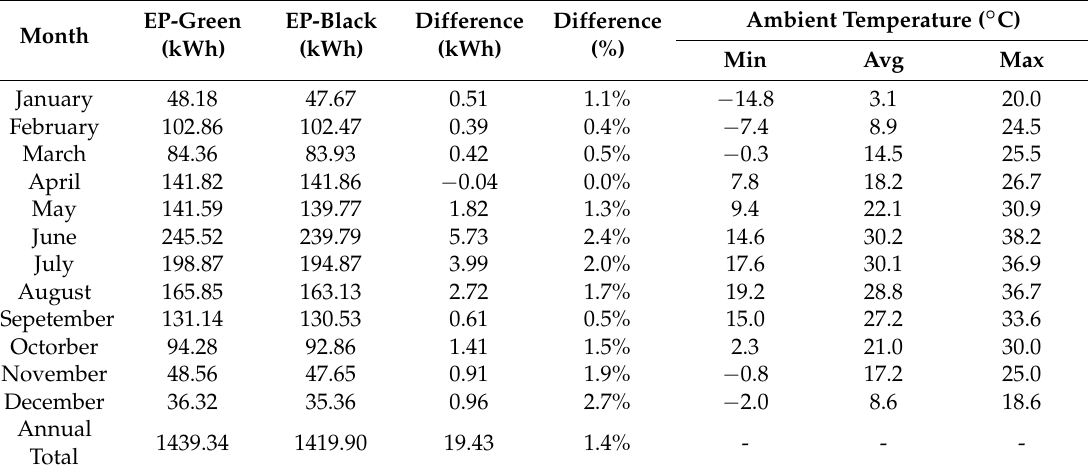
Table 4. Monthly energy production and differences for EP-Green and